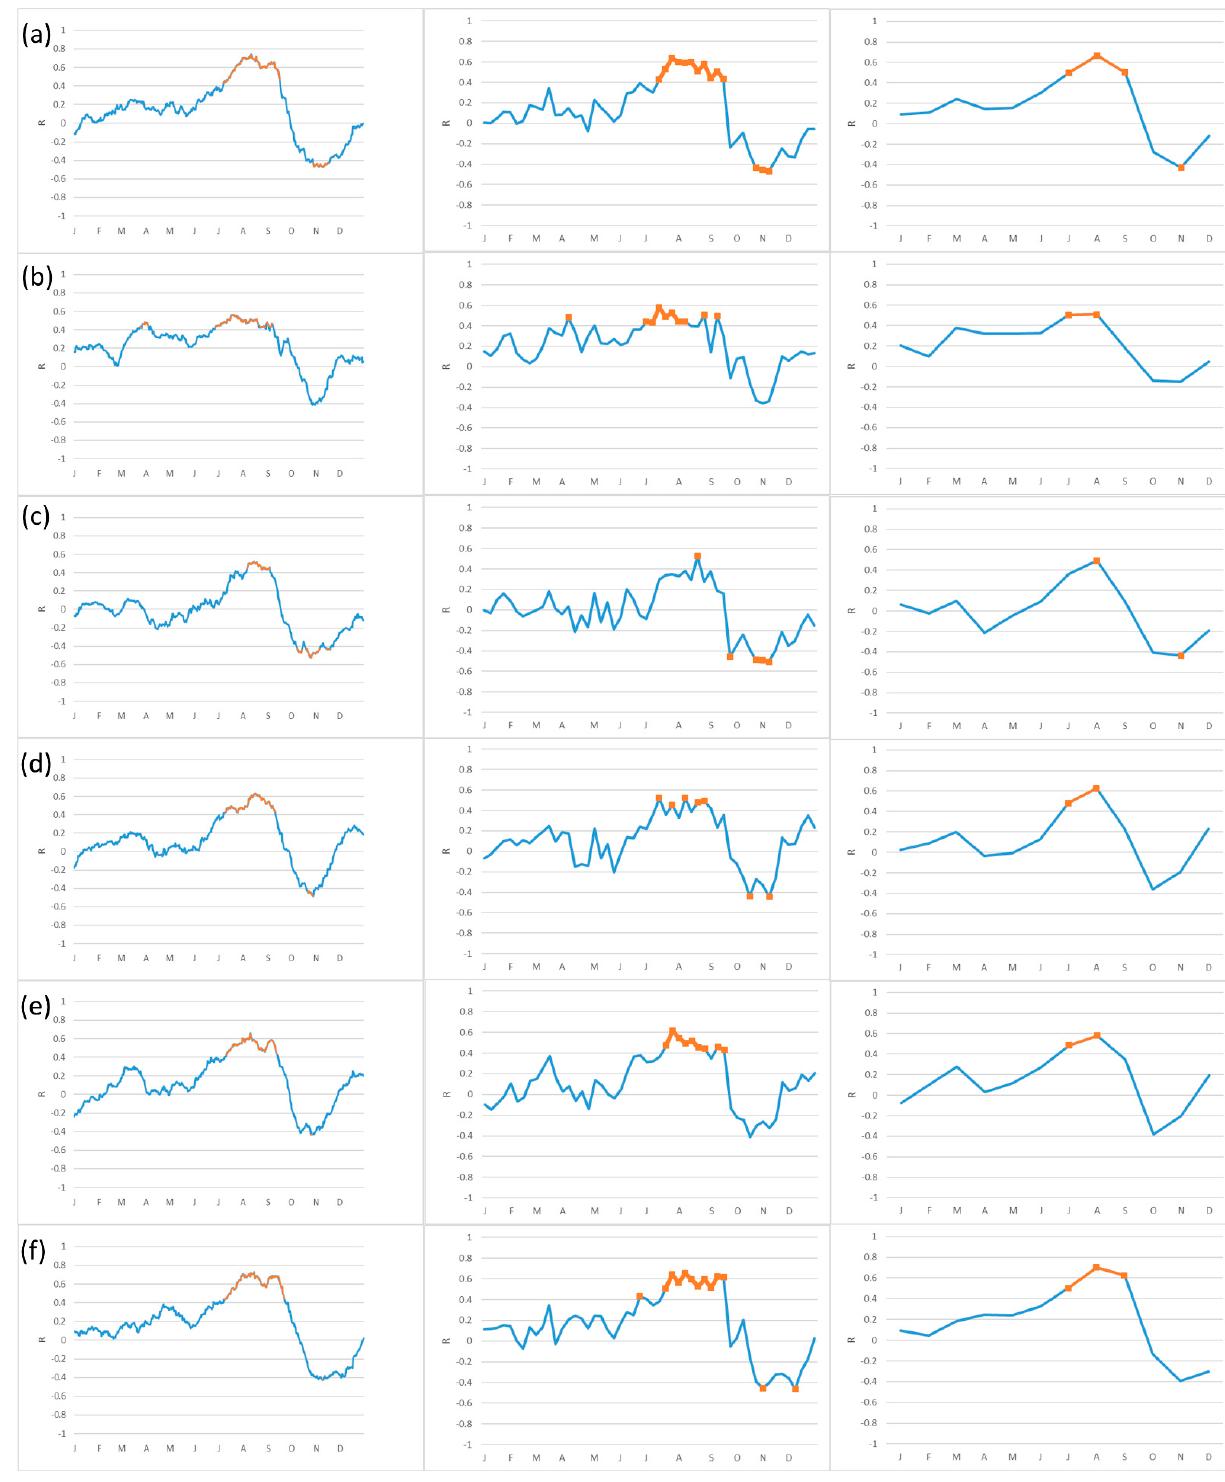
Figure 2. Temporal evolution of correlation coefficient values obtained with the samples-average approach between SM and black truffle production for daily data (left column), weekly data (middle column) and monthly data (right column). ( a ) Iberian Peninsula; ( b ) Betic Range; ( c ) Pyrenees; ( d ) North Iberian Range; ( e ) Central Iberian Range; ( f ) South Iberian Range. Orange points are R values with p value < 0.05.